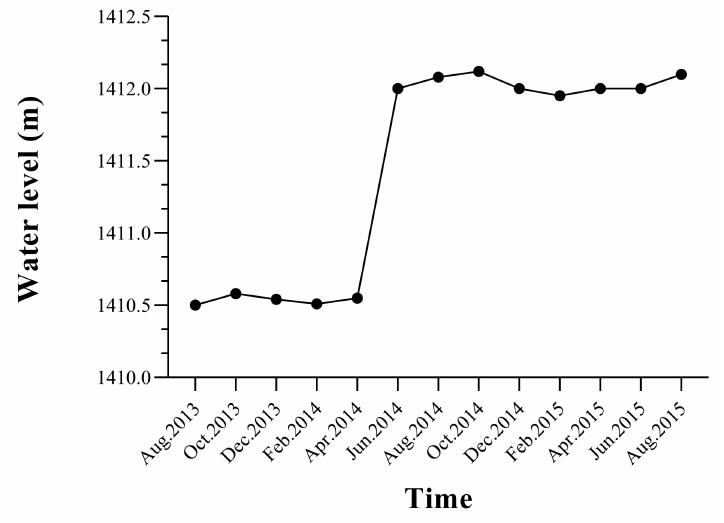
Figure 1. Time-course of the water level statistics of Yilong Lake during the